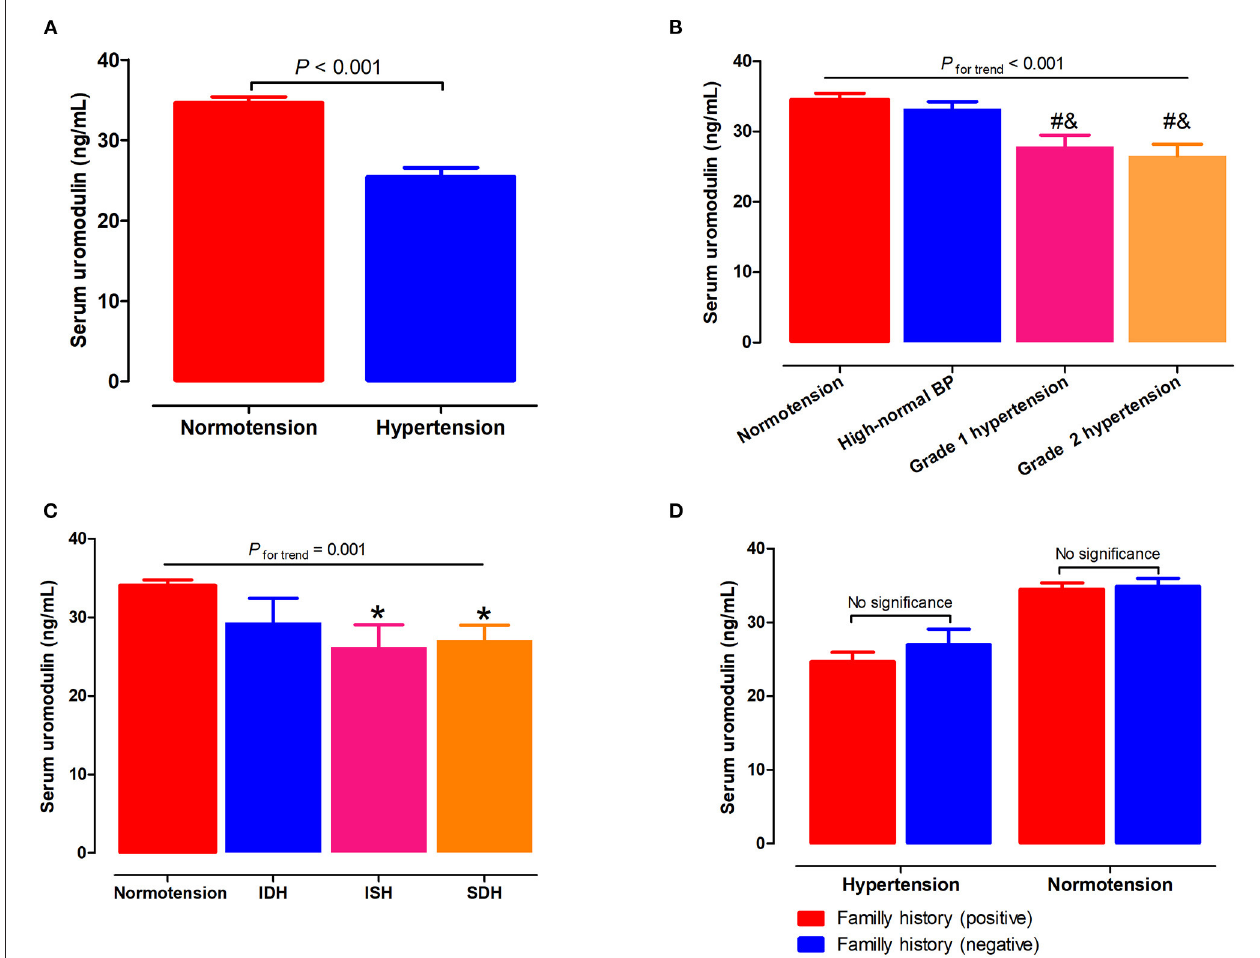
FIGURE 1 | Associations of serum uromodulin with BP levels and hypertension. (A) Serum uromodulin levels in subjects with normotension and hypertension. (B) Serum uromodulin levels in subjects with different grades of BP, including normotension, high-normal, grade 1 hypertension, and grade 2 hypertension. # P < 0.05 vs. normotension, & P < 0.05 vs. high-normal BP. (C) Serum uromodulin levels in subjects with normotension and different hypertensive subtypes, including ISH, IDH, SDH, and those with controlled and uncontrolled BP in the absence of antihypertensive treatment. * P < 0.05 vs. normotension. (D) Serum uromodulin levels in hypertensive or normotensive subjects with a family history of hypertension and those without. BP, blood pressure; ISH, isolated systolic hypertension (SBP ≥ 140 mmHg and DBP < 90 mmHg); IDH, isolated diastolic hypertension (SBP < 140 mmHg and DBP ≥ 90 mmHg); SDH, systolic diastolic hypertension (SBP ≥ 140 mmHg and DBP ≥ 90